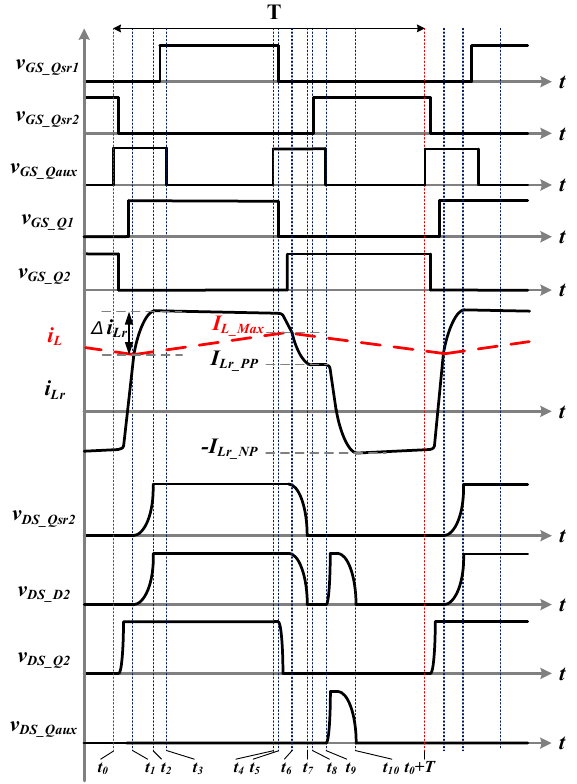
Figure 8. Bilateral ZVS synchronous rectified step-down converter operation waveform (forward mode).